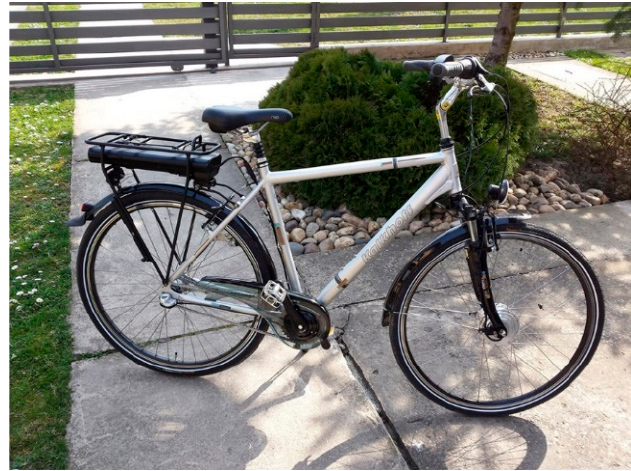
Figure 2. “Kalkhoff Groove 28” bicycle.